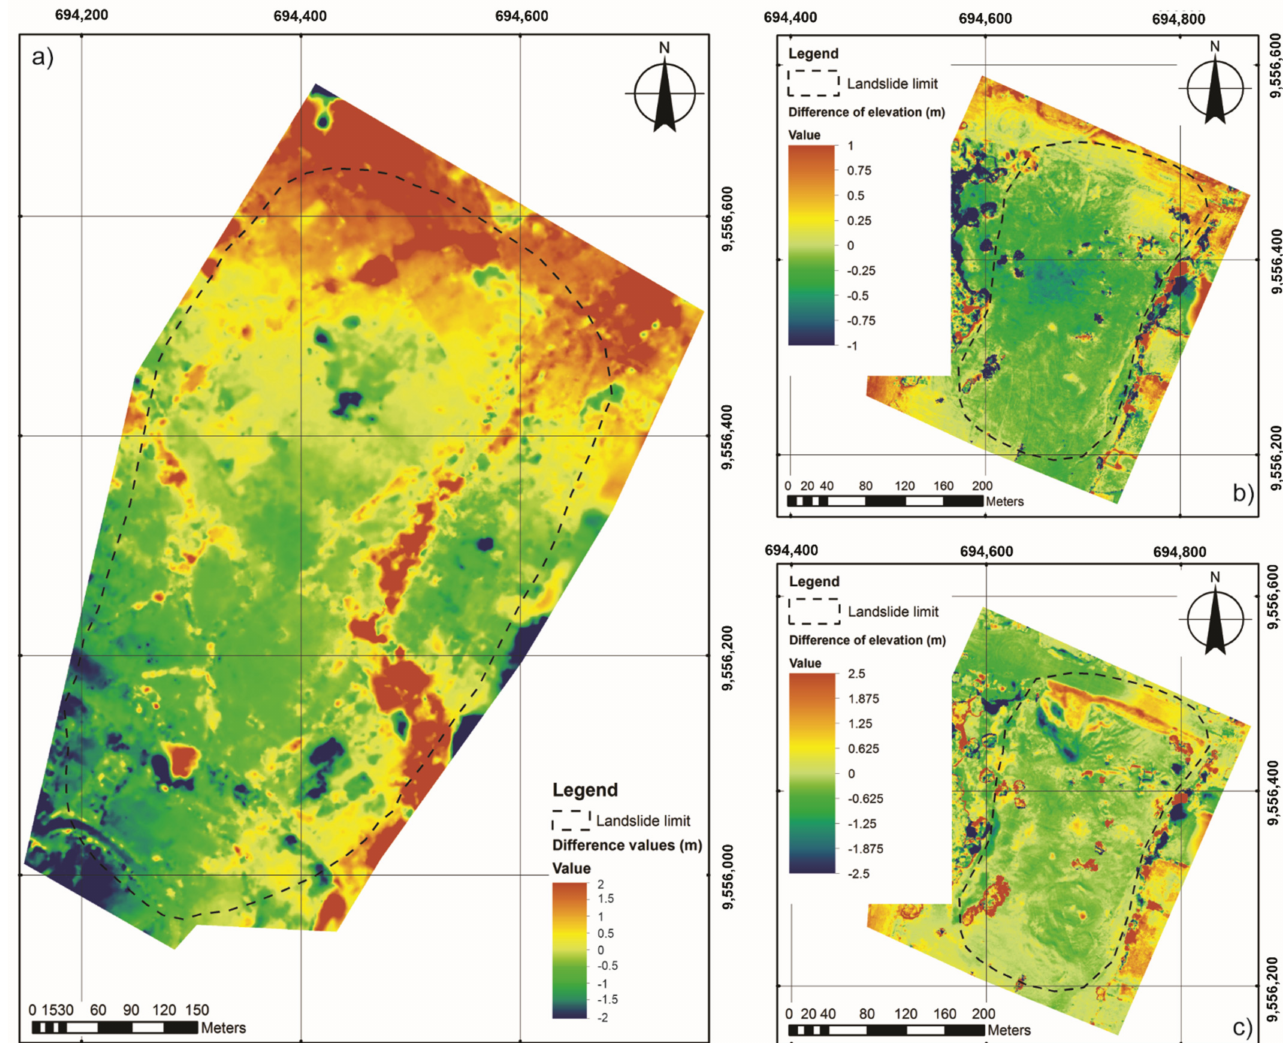
Figure 9. DoD maps: ( a ) corresponding to Victoria (18 February 2016–11 June 2016); ( b ) Colinas Lojanas (July–November 2016 period); and ( c ) Colinas Lojanas (November 2016–January 2018